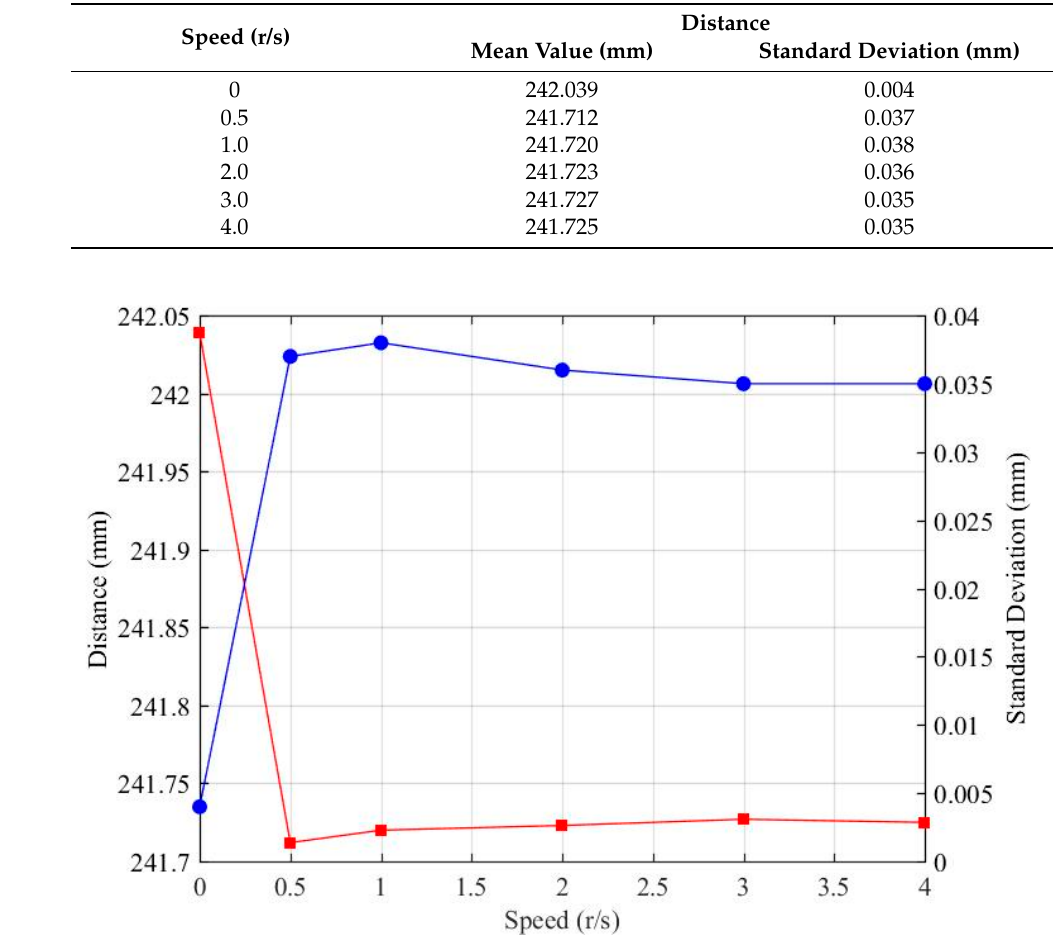
Table 4. Calculation results at different speeds.